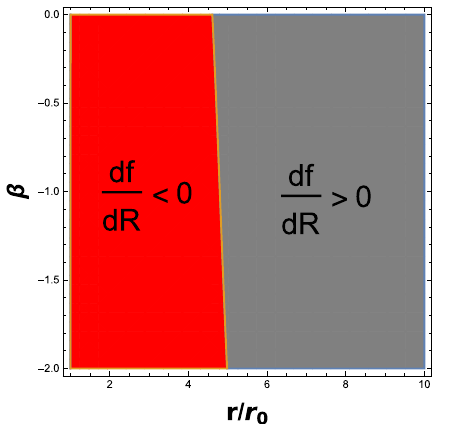
Fig. 2 For shape function (cid:6)( r ) = ( r 0 ) n + 1 r − n with r 0 = 2 Km, α = 20 , β = − 0 . 1 and 0 ≤ n ≤ 2. Above three plots shows the behaviour of ρ , ρ + p r and ρ + p t , and below three plots are their cor-